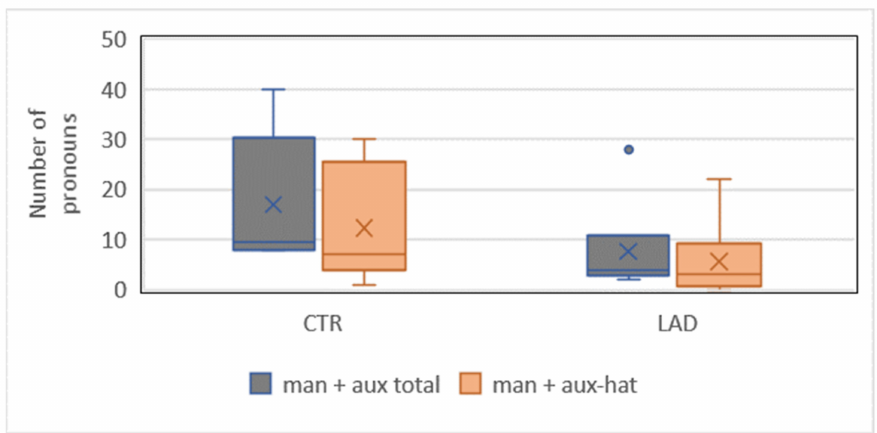
Figure 8. Proportion of man ‘one’ + auxiliary in total and man + auxiliary hat ‘has’ in the CTR group and the LAD group.